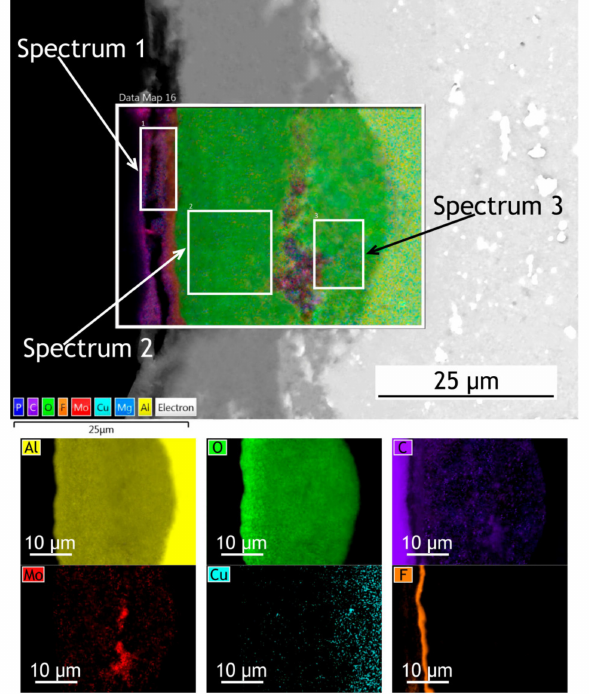
Figure 17. SEM image and EDX maps of the CC’s